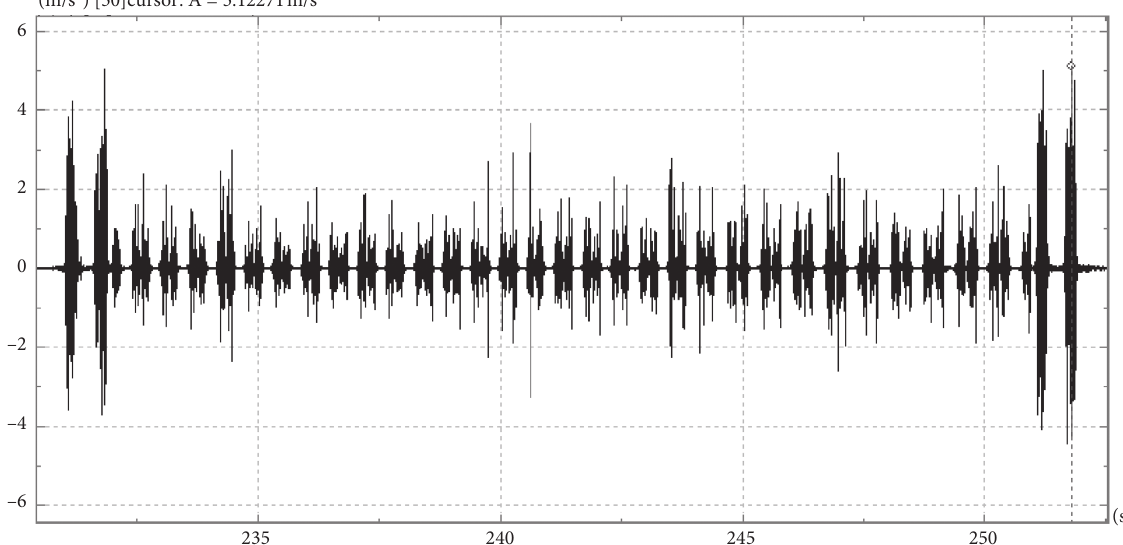
Figure 19: Time domain characteristic diagram of vibration acceleration along the line direction ( Y -axis) in the fracture zone.